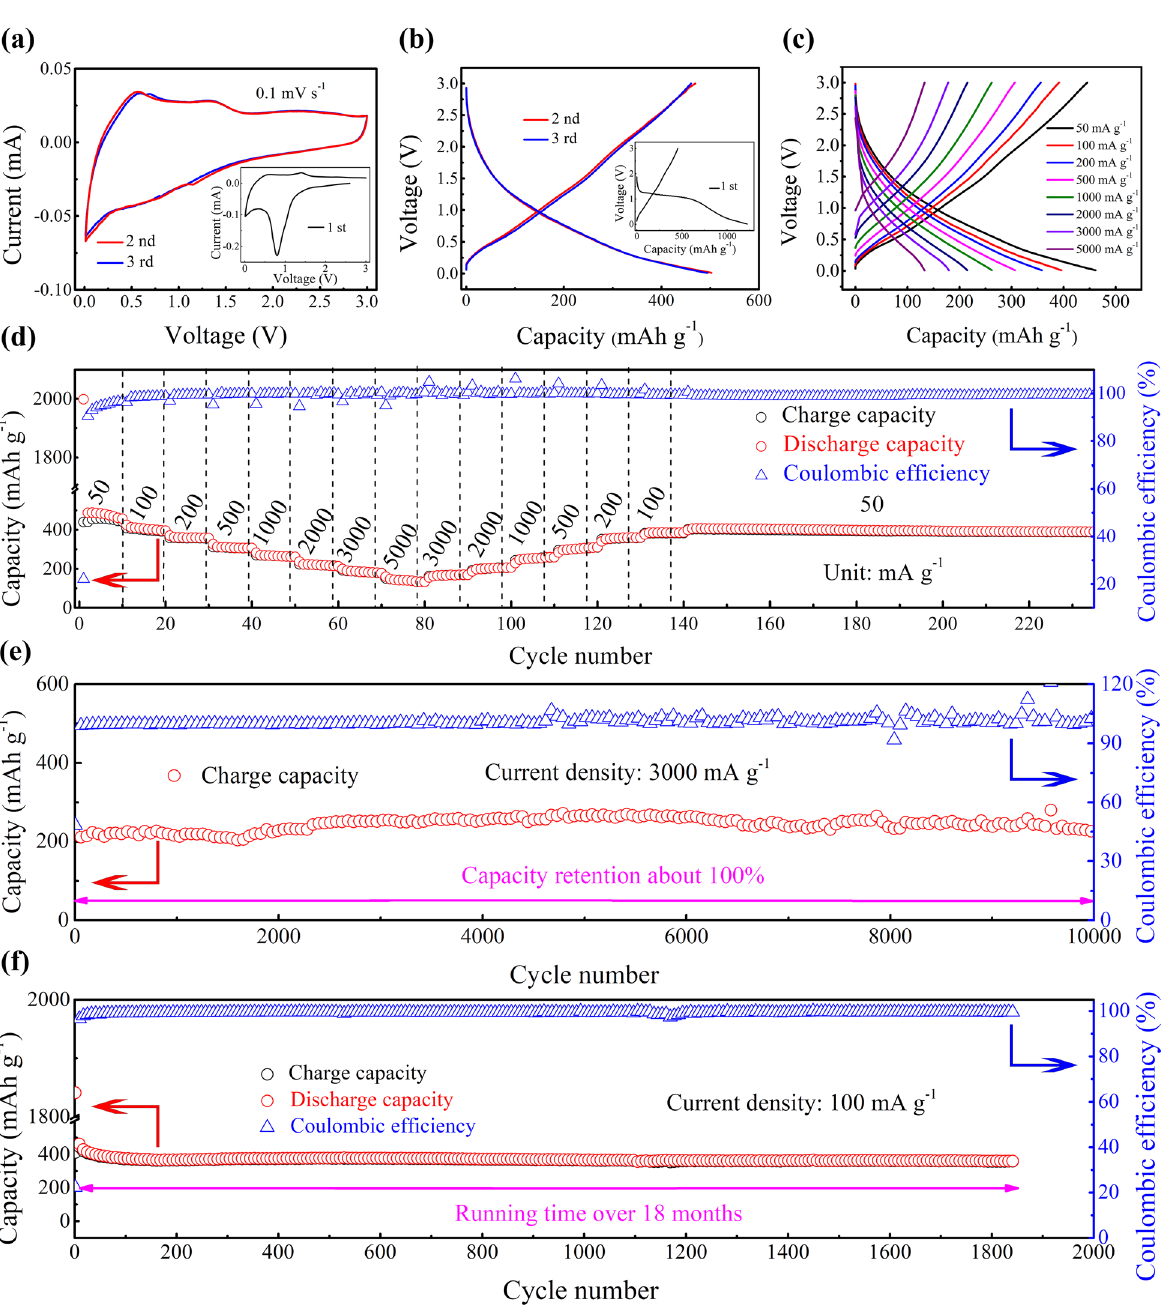
Fig. 3 Cycle performance of as-synthesized OFGC-600 electrode. a CV curves of an as-fabricated OFGC-600 anode at the scanning rate of 0.1 mV s −1 (the inset is the first circle). b The galvanostatic charge/discharge curves for the first three cycles in the potential range of 0.01 − 3.0 V at 50 mA g −1 . c‑d Rate capability of OFGC-600 in the rate range from 50 to 5000 mA g −1 . e Long-term cycle performance of OFGC-600at 3000 mA g −1 over 10,000 cycles. f Long-term cycle performance of OFGC-600 at a current density of 100 mA g −1 over 18